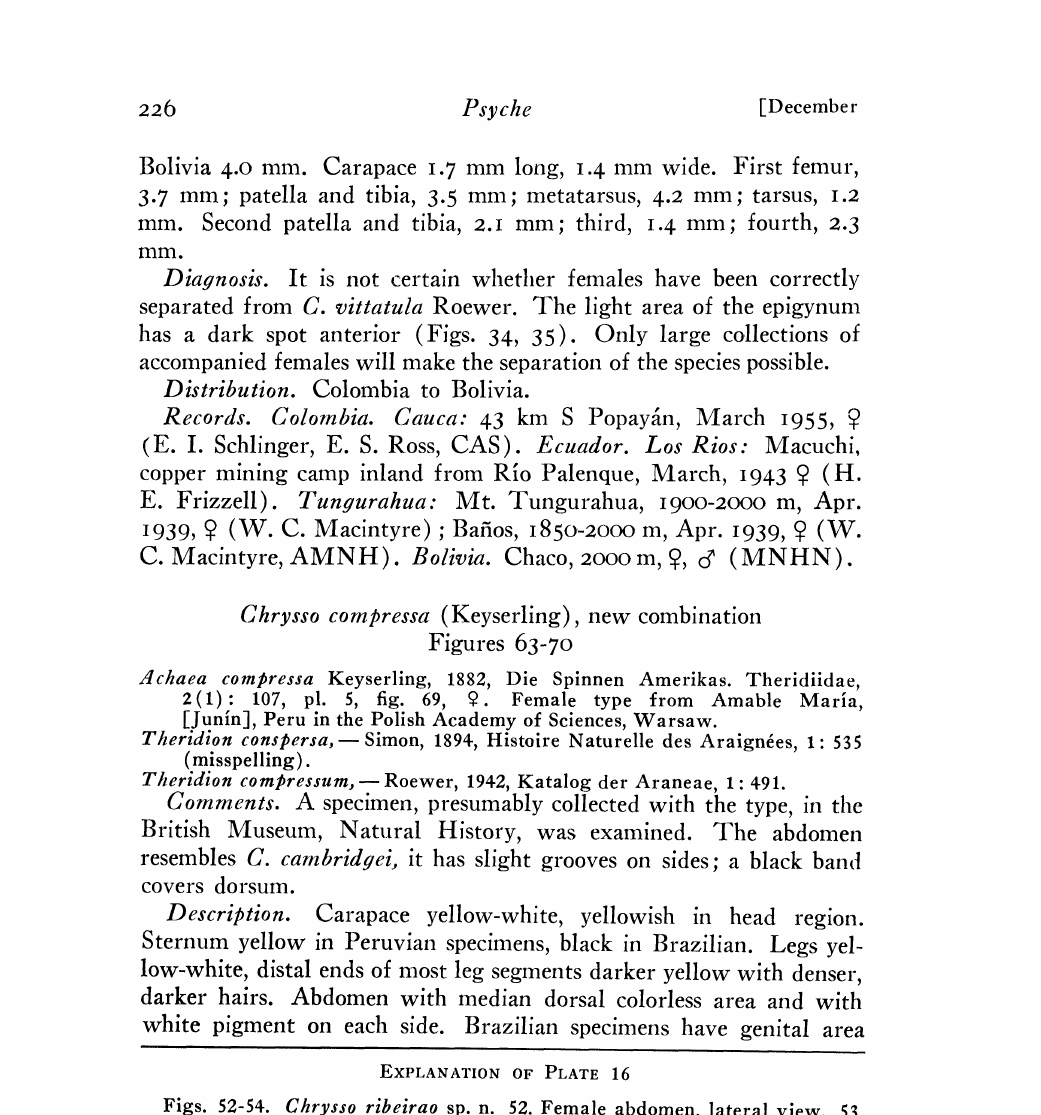
Figs. 52-54. Chrysso ribeirao sp. n. 52. Female abdomen, lateral view. 53. Female genitalia, dorsal view. 54. Epigynum. Figs. 55-57. C. pulchra (Keyserling). 55. Female abdomen, lateral view. 56. Female genitalia, dorsal view. 57. Epigynum. Figs. 58-60. C,. backstromi (Berland). 58. Female. 59. Female genitalia, dorsal view. 60. Epigynum. Figs. 61, 62. G. caraca sp. n. 61. Female genitalia, dorsal view. 62. Epigy- num. Figs. 63-70. C. compressa (Keyserling). 63, 65. Female genitalia, dorsal view. 64, 66, 67. Epigynum. 68. Female abdomen, lateral view. 69, 70. Left